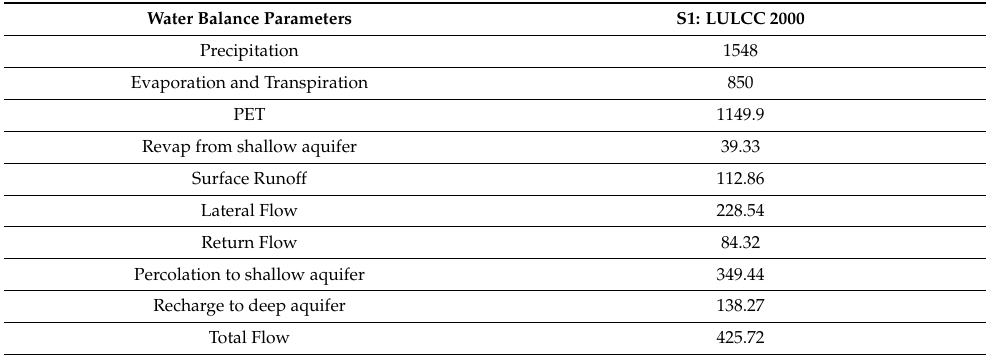
Table 7. Water balance simulated by SWAT between 2000 and 2021 with LULCC 2000 (S1) in the Paraopeba River Basin.